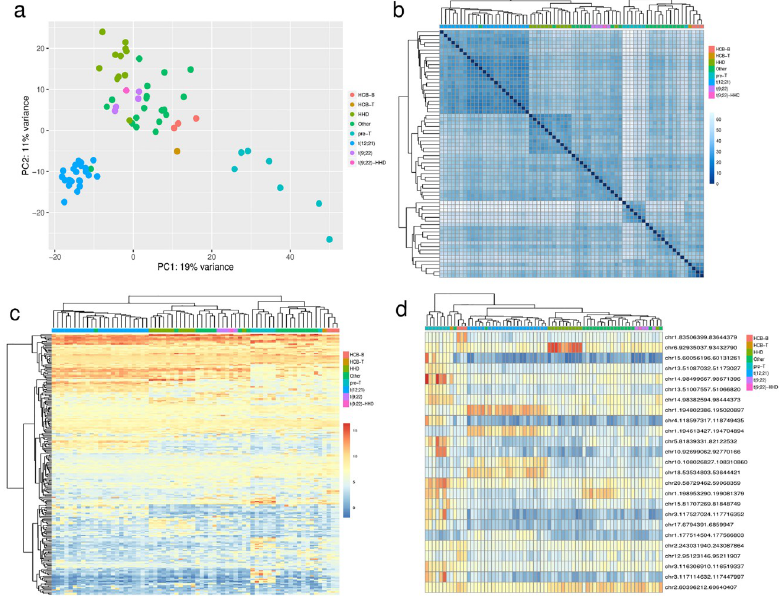
Fig 2. Subtype-specific classification of cALL using vlincRNA expression profiles. (A) PCA plot of the discovery samples (n = 68) using the DESeq2 regularized log transform (rld) normalized read counts of minimally expressed cALL vlincRNAs (n = 256). (B) Hierarchical clustering of discovery samples using Euclidean distance on vlincRNA normalized rld expression values. Cluster purity = 0.85 using 8 clusters. (C) Heatmap of vlincRNA normalized rld expression values in the discovery samples. (D) Heatmap of normalized rld expression values of the top 25 significantly differentially expressed cALL vlincRNAs (adj. p-value < 0.05) in the discovery samples using the likelihood ratio test on subtypes with DESeq2. HCB-B: CD19 + CD10 + pre-B cells isolated from human cord blood. HCB-T: CD3 + pre-T cells isolated from human cord